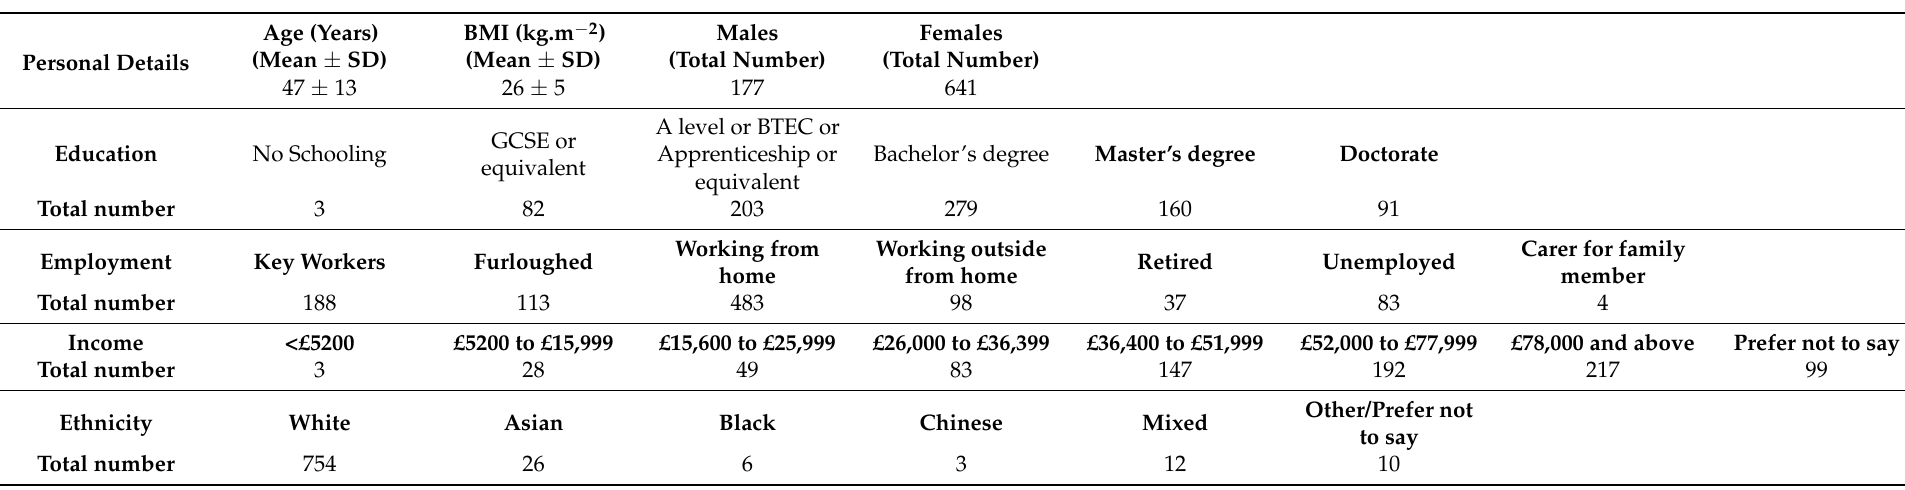
Table 1. Participant Characteristics ( n =